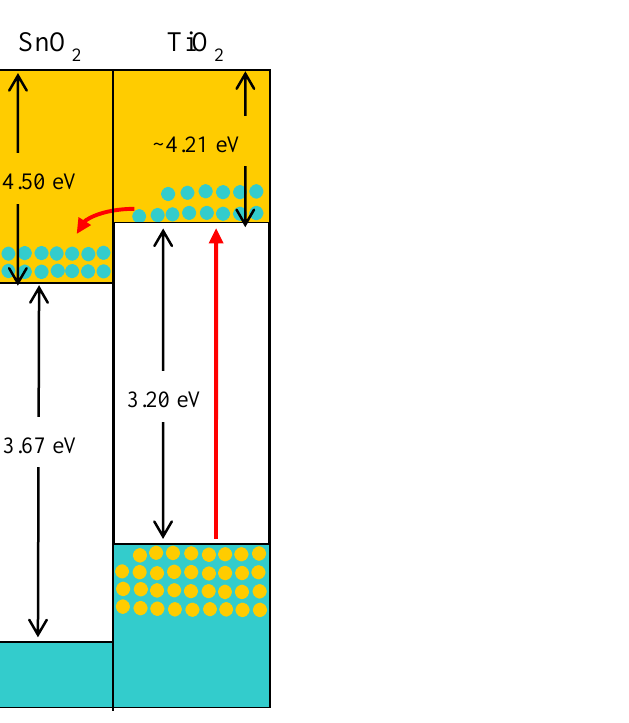
Figure 7. Schematic energy band diagrams of TiO 2 /SnO 2 heterojunction showing the electron-hole separation mechanism after UV light irradiation.